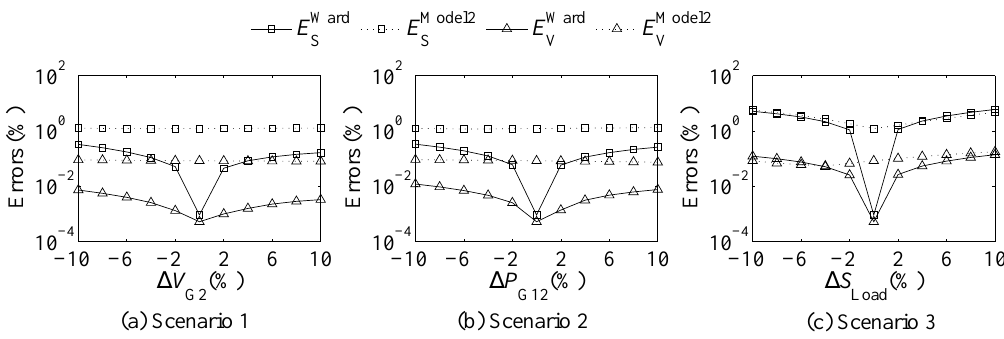
Figure 13. Relative errors produced by the two models in the different